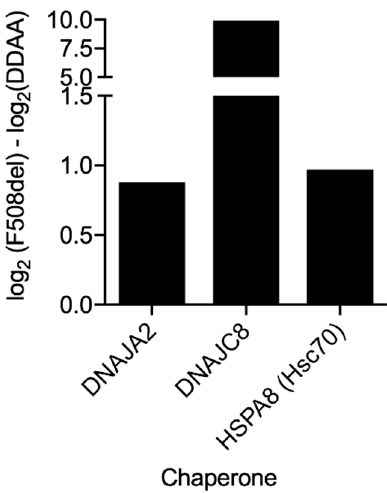
Figure 8. Association of f508del-CFTR with chaperones compared to DD / AA-CFTR. The protein a ffi nity for the two variants under analysis was assessed by calculating log 2 (Condition 1) − log 2 (Condition 2) | and shown for variants with − log 10 ( p -value) ≥ 1.6 (corresponding to p < 0.025) as in Figure 4 (see Materials and Methods).